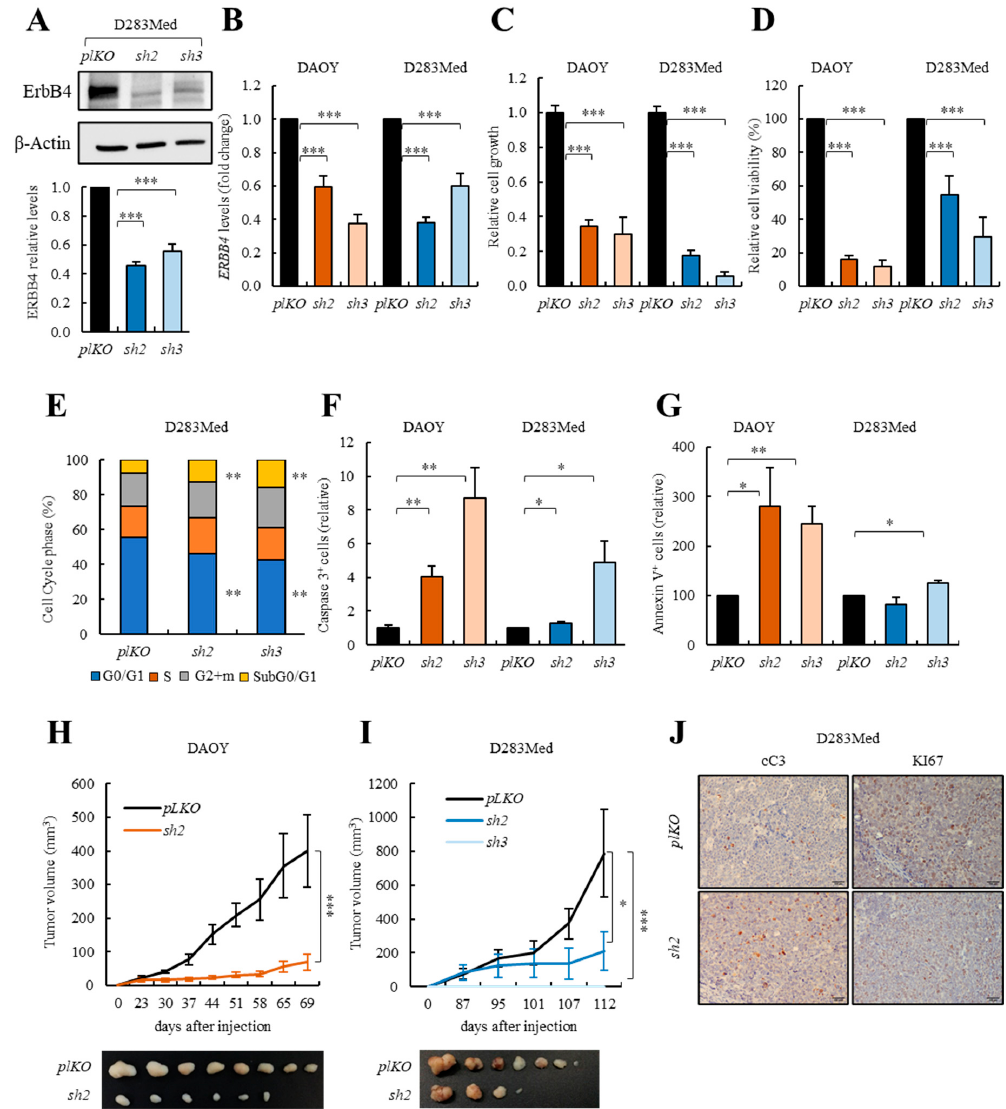
Figure 4. ERBB4 knock-down impairs medulloblastoma cell viability in vitro and tumor progression in vivo. ( A ) Representative image and quantification of Western blot analysis of ERBB4 in control ( pLKO) and shERBB4 ( sh2 and sh3 ) D283Med cells ( n = 4). ( B ) ERBB4 mRNA expression in control ( pLKO ) and shERBB4 ( sh2 and sh3 ) cells ( n ≥ 9). ( C ) Relative cell growth at day 5 comparing pLKO with sh2 and sh3 cells ( n ≥ 6). ( D ) MTT studies measuring cell viability in sh2 and sh3 relative to pLKO cells ( n ≥ 6). ( E ) Cell cycle assay measuring the number of cells in each cell cycle phase in pLKO, sh2 , and sh3 D283Med cells ( n ≥ 3). ( F ) Immunofluorescence quantification of cleaved-Caspase-3 (cC3) positive cells in sh2 and sh3 relative to pLKO DAOY and D283Med cells ( n ≥ 4). ( G ) Percentage of Annexin-V positive cells in pLKO, sh2 and sh3 DAOY and D283Med cells ( n ≥ 3). ( H – I ) Volume of tumors generated after subcutaneous injection of DAOY and D283Med pLKO, sh2 and sh3 cells ( n ≥ 8) at the indicated time points. ( J ) Representative images of the immunohistochemical staining of cC3 and KI67 in tumors generated after subcutaneous injection of D283Med pLKO and sh2 cells ( n = 5). Scale bars = 100 µ m. The uncropped blots and molecular weight markers are shown in Figure S11. * p ≤ 0.05; ** p ≤ 0.01; and *** p ≤